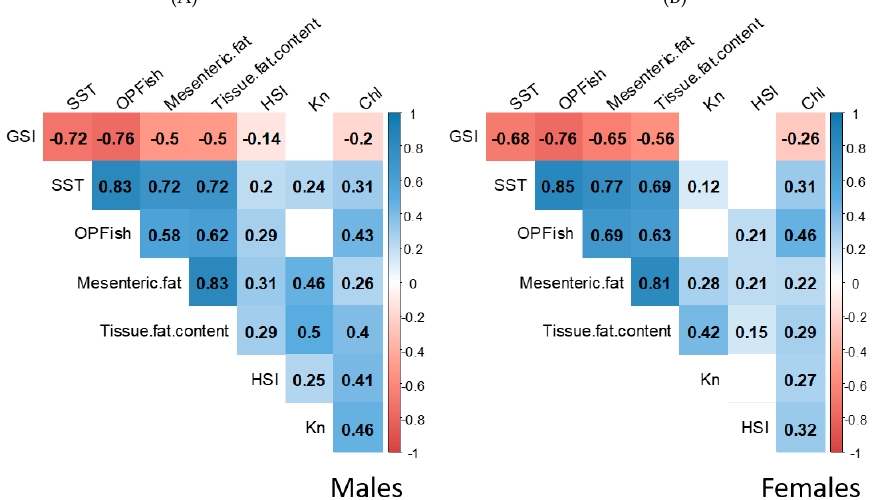
Figure 4. Spearman correlation matrix among the European sardine’s ( S. pilchardus ) condition parameters and the environmental variables considered in males ( A ) and females ( B ). Relative condition index (Kn), tissue fat content (%), mesenteric fat scale, gonadosomatic index (GSI; %), and hepatosomatic index (HSI; %) were correlated with each other and with the following environmental variables: sea surface temperature (SST; °C), chlorophyll-a concentration (Chl; mg·m − 3 ), and available portion of productivity for the fish (OPFish; %). The colour gradient from maroon to navy blue corresponds to the correlation with strength, from negative to positive, respectively. The empty squares represent a non-significant correlation according to a p value of < 0.05 *.